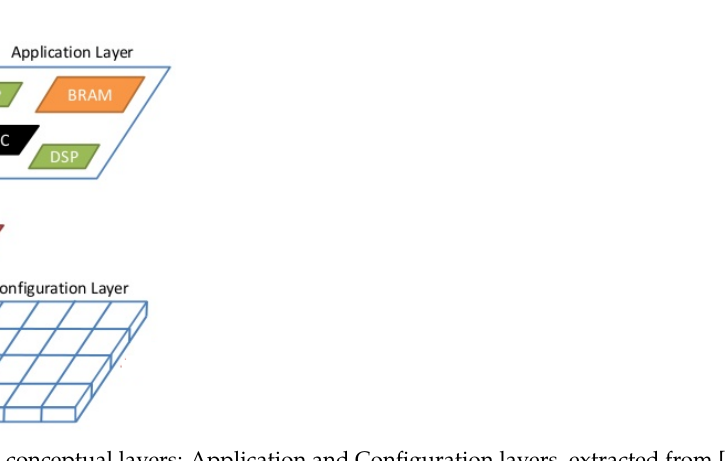
Figure 5. Xilinx FPGA conceptual layers: Application and Configuration layers, extracted from